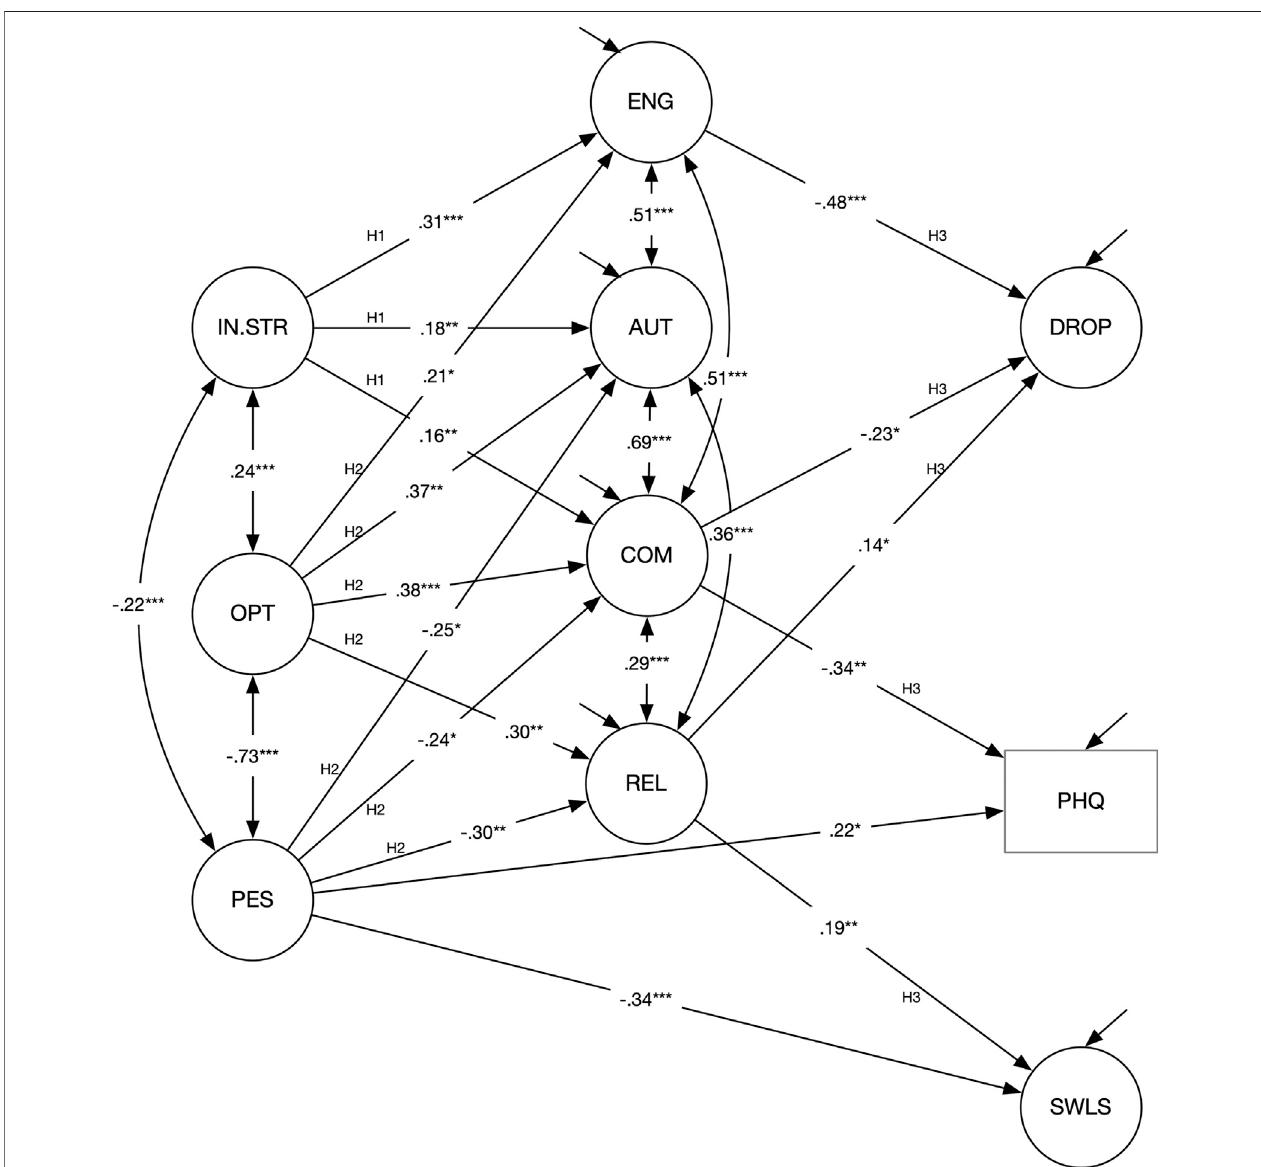
FIGURE1| The fi nalSEMmodel.Note .* p < 0.05.** p < 0.01.*** p < 0.001.IN.STR,satisfactionwithinstitutionalstrategies;AUT,needsforautonomy;COM,needs forcompetence;REL,needsforrelatedness;OPT,optimism;PES,pessimism;ENG,academicengagement;DROP,intentiontodropoutofstudies;SWLS,satisfaction withlife;PHQ,depression.Forsakeofsimplicity,controlvariablesandtheirpathcoef fi cientsaswellasnon-signi fi cantpathcoef fi cientsarenotdepictedbutestimatedin the